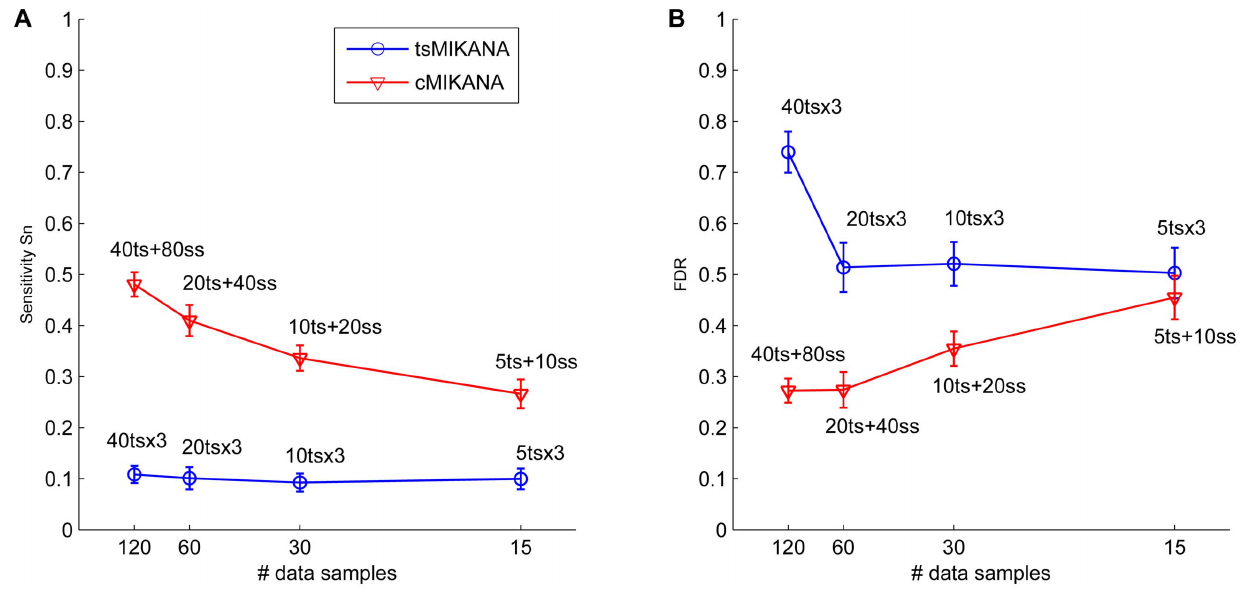
Figure 2. The performance of tsMIKANA and cMIKANA inference methods on the same size of data samples for scale-free networks with 100 genes. The sensitivities and false discovery rates (FDRs) from MIKANA inference methods with time-series data only (tsMIKANA) and with the combination of steady-state and time-series data (cMIKANA) are compared. We reconstructed tsMIKANA network models from time-series datasets – each contained 5, 10, 20 and 40 data samples in 3 replicates, providing 15, 30, 60 and 120 data samples, respectively. We also reconstructed cMIKANA network models from the combined datasets with the same size – containing time-series data sample from 1 temporal experiment (5, 10, 20 and 40 time-series data samples, respectively) and the remainder samples were collected from several knockdown experiments (containing 10, 20, 40 and 80 steady-state data samples, respectively). 10% noise was added to both time-series and steady-state data. Being reconstructed from the same sizes of data, cMIKANA models showed higher sensitivity and relatively lower FDRs compared with tsMIKANA models, suggesting the prediction of gene regulatory interactions could be improved by incorporating steady-state data.